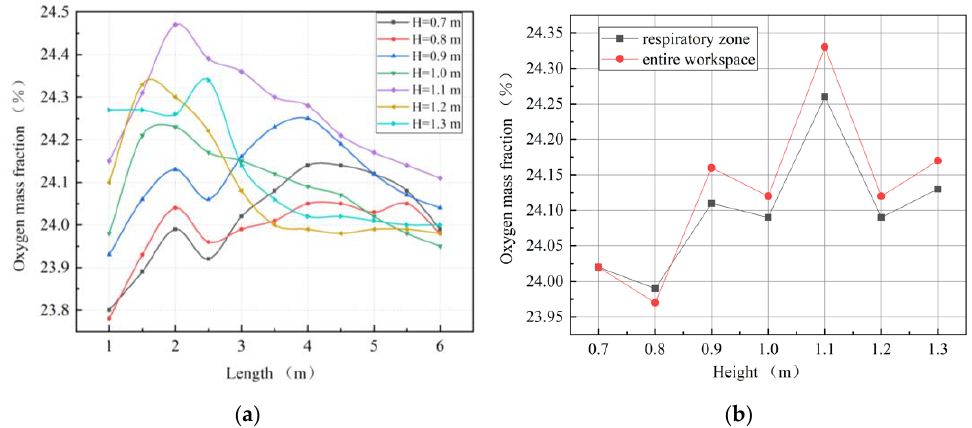
Figure 8. Characteristic diagrams of oxygen mass fraction distributions in main working area. ( a ) Oxygen mass fractions along the roadway; ( b ) oxygen mass fractions in the respiratory zone and in the entire workspace.